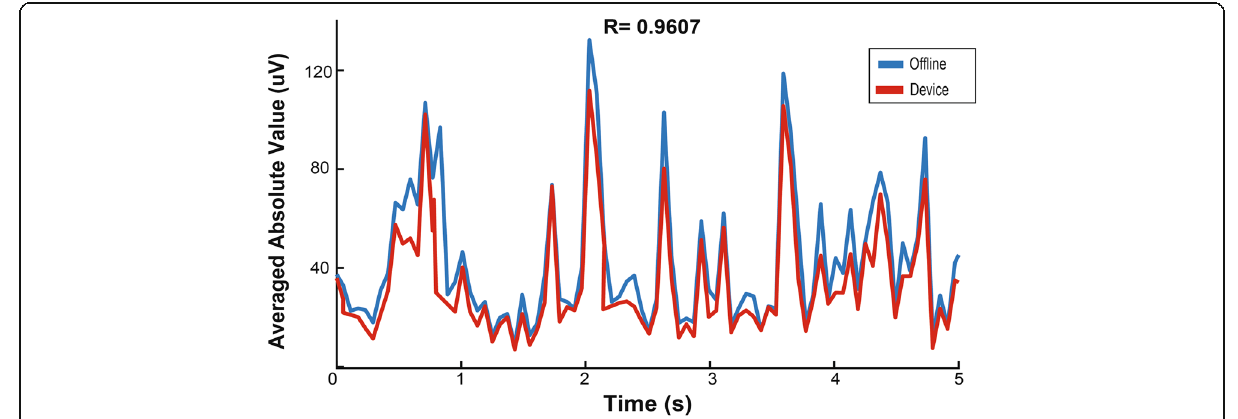
Fig. 9 Power calculated from 2 kSps data offline compared to data output from the device on a single